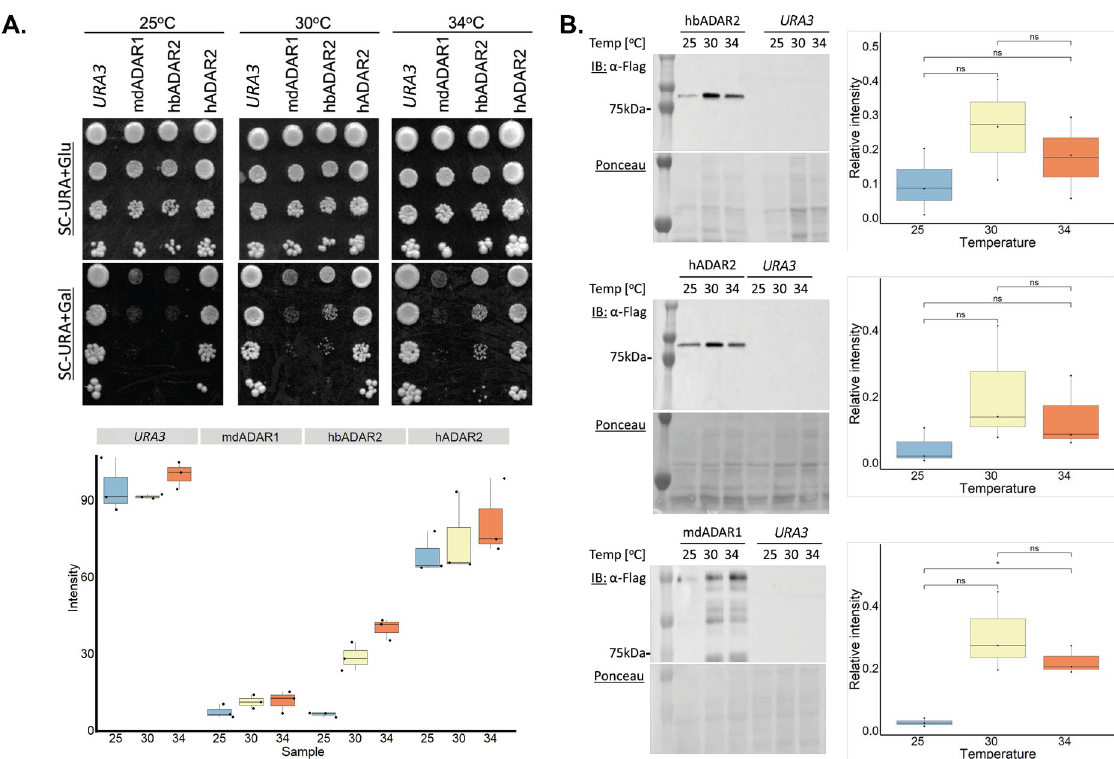
Fig 5. The growth of yeast cells carrying heterologous ADARs is differentially affected by temperature change. (A) Similar to 1D, this time plates were incubated at 25˚C, 30˚C or 34˚C for 40h. (B) Protein levels of the ADAR proteins in A are not significantly affected by the temperature shift. Similar to 1C, this time samples from the SC-URA+Gal media were incubated at 25˚C, 30˚C or 34˚C for 6 hours. Cells harboring an empty URA3 marked plasmid were used as a negative control ( URA3 ). Ponceau staining was used a loading control. Protein levels were quantitated relative to the loading control in three independent experiments. Stars above the boxplots indicate a statistically significant difference between the means of two samples (ns: p > 0.05; � : p < = 0.05).